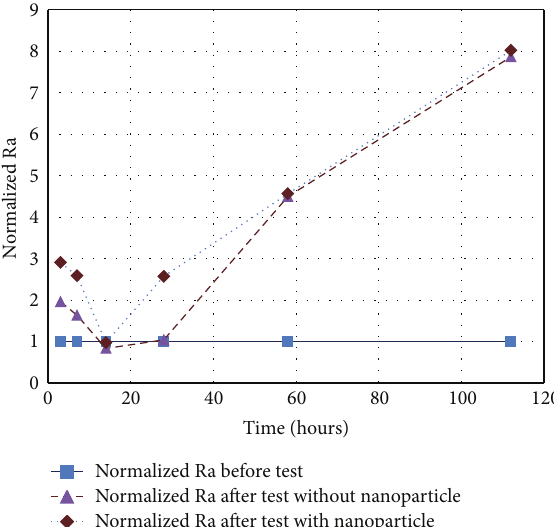
Figure 3: Normalized Ra roughness for 3003-T3 aluminum before and after 3-, 7-, 14-, 28-, 56-, and 112-hour treatments with the refer- ence fluid of 50/50% Ethylene glycol in water and with nanofluid of 2% nanoalumina in reference